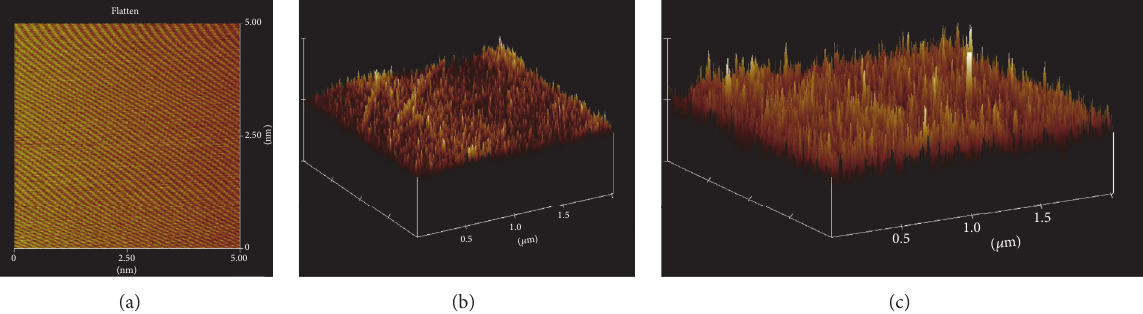
Figure 1: In situ STM images of an HOPG electrode recorded before (a) and after being treated with APBA (b) and further with Ru(bpy) 2 (phendione) 2+ (c).